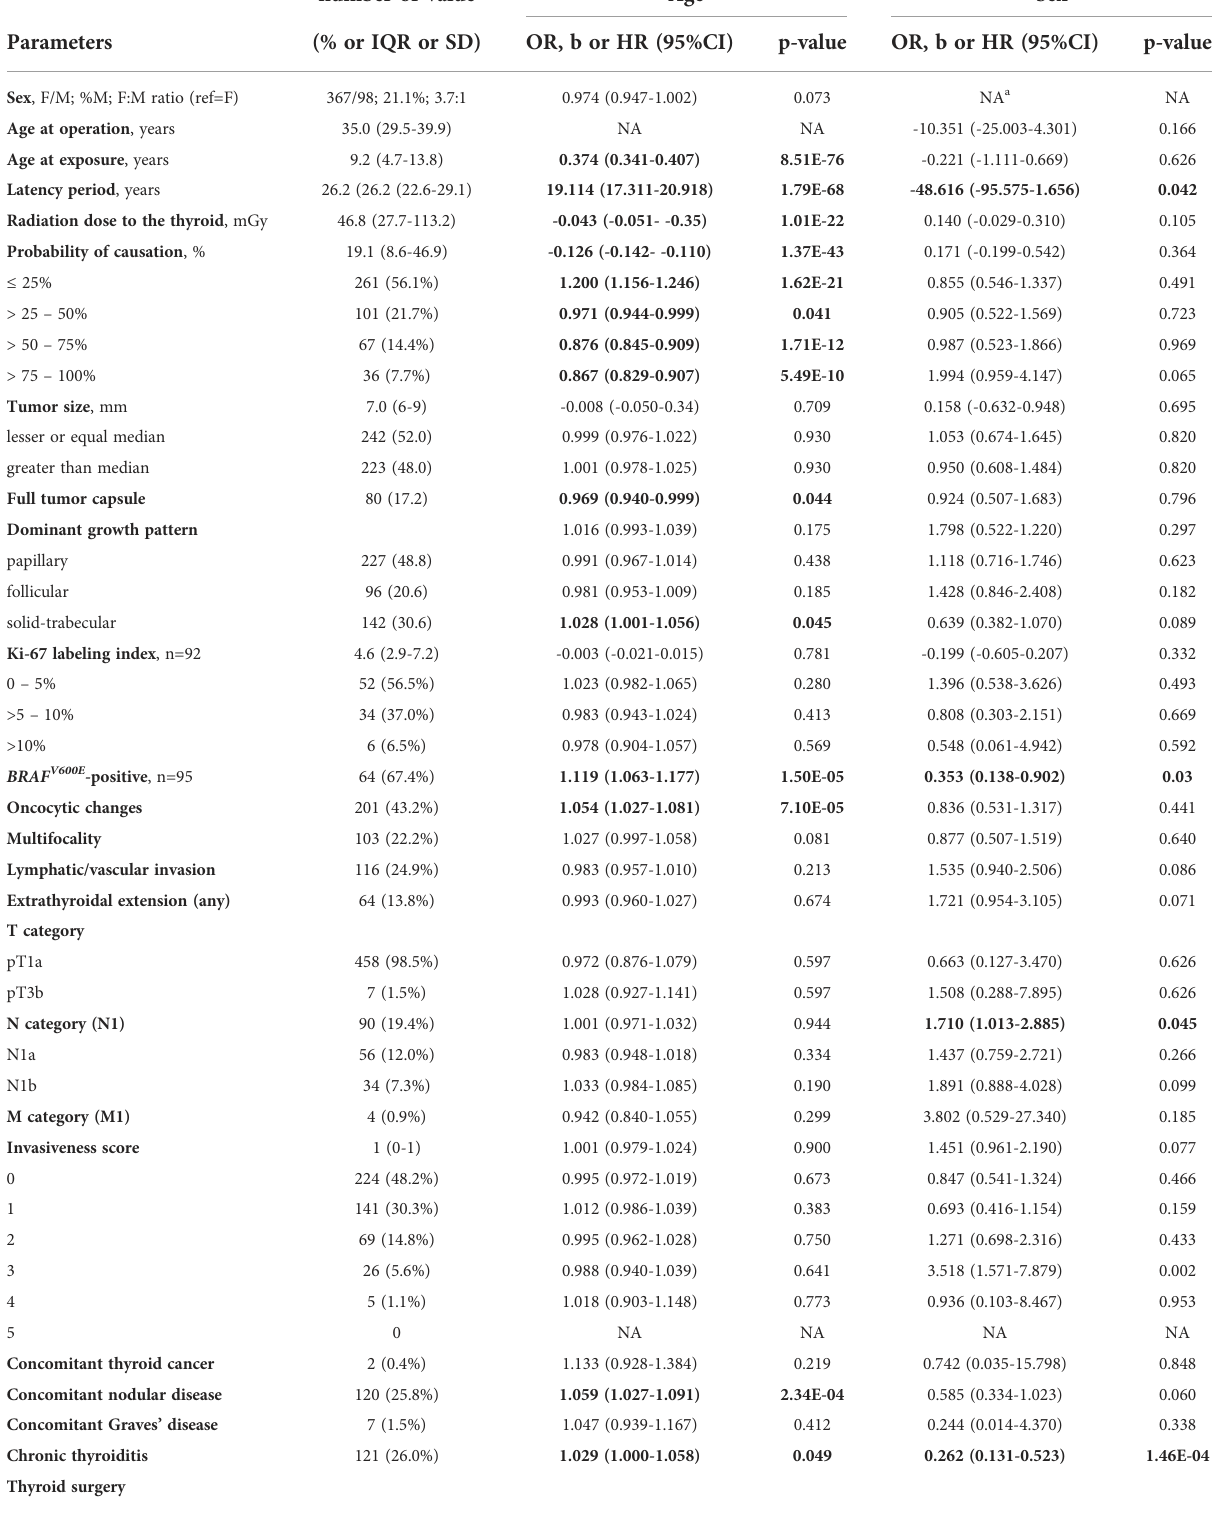
TABLE 1 Descriptive characteristics of the 465 radiogenic papillary thyroid microcarcinomas in the study and their associations with patient age and